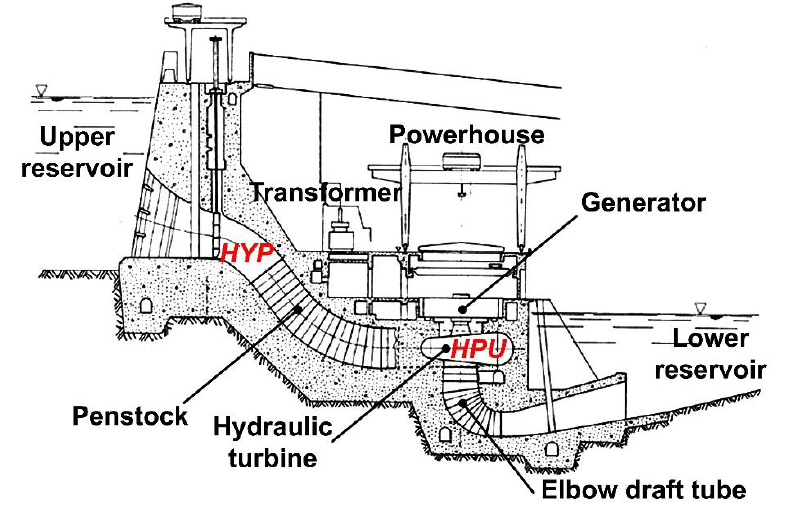
Figure 1. Schematic view of a hydroelectric power plant: Hydro Power Unit (HPU) and Hydraulic Passage (HYP).